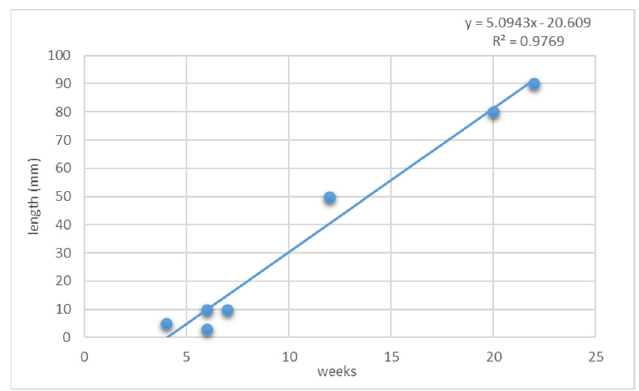
Figure 7. Length variation (mm) in newly obtained blades during the experiment .